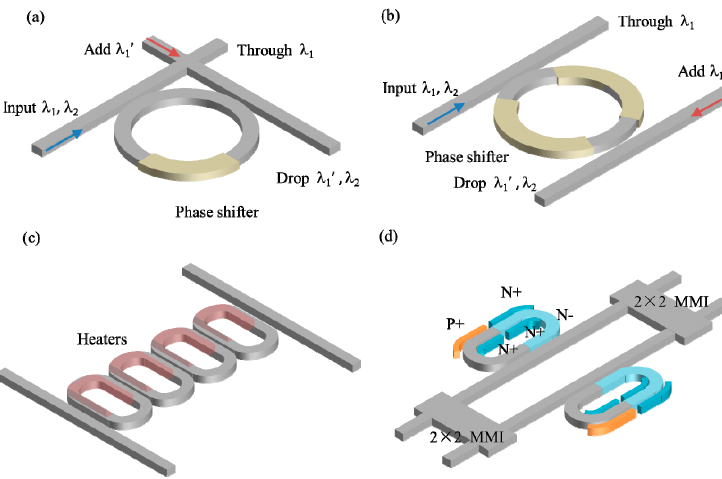
Figure 3. Schematic of ( a ) MRR switch with input and output crossing ( b ) MRR switch with input and output parallel ( c ) High-order MRR switch ( d ) MRR assisted MZI switch.